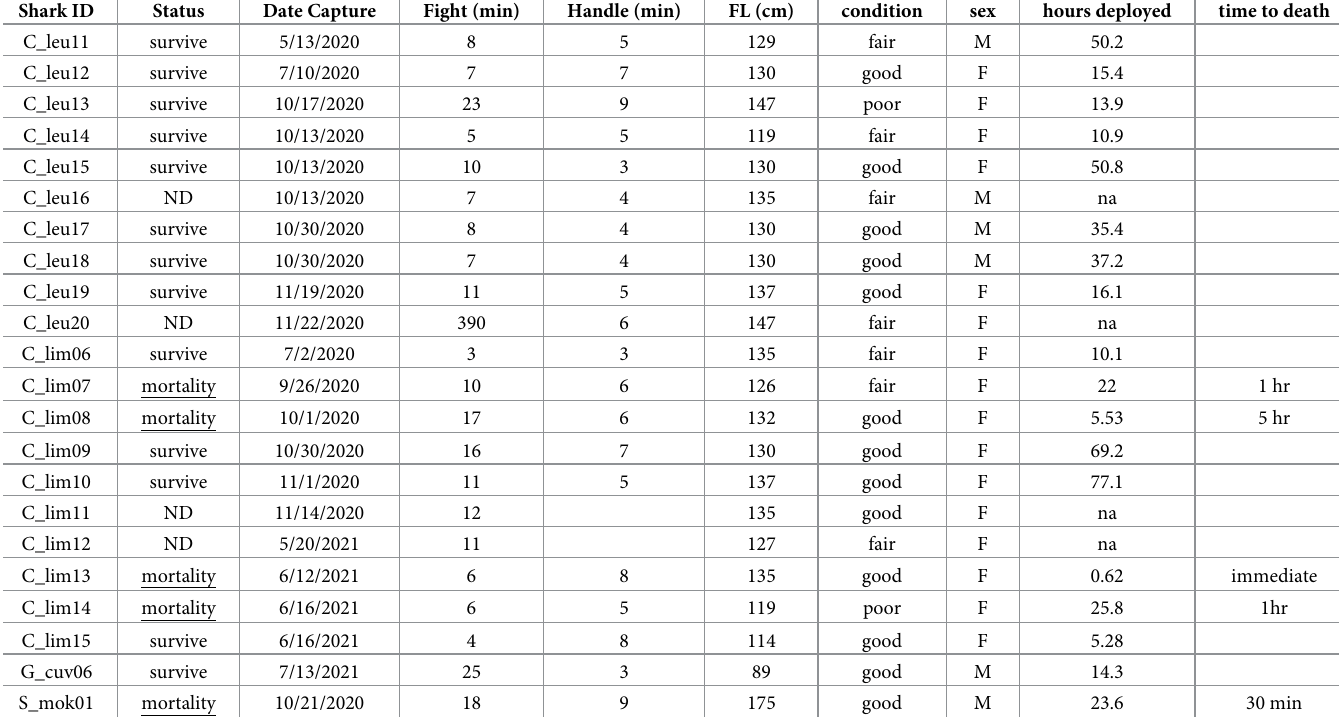
Table 3. Results of 22 ADL tags deployed on bull sharks, blacktip sharks tiger sharks, and great hammerheads in the Gulf of Mexico by shore-based recreational anglers. FL = fork length, ND = no data. Underlined individuals indicate instances of